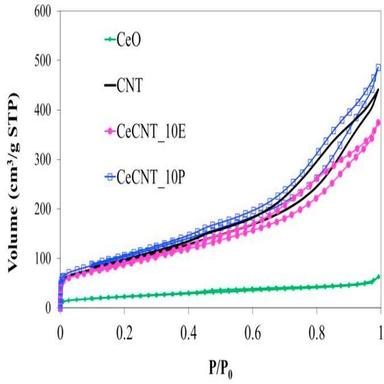
N2 adsorption-desorption isotherms at −196 °C for pure cerium oxide, pristine carbon nanotubes and the composites prepared by the evaporation (CeCNT_10E) and the precipitation (CeCNT_10P) methods.